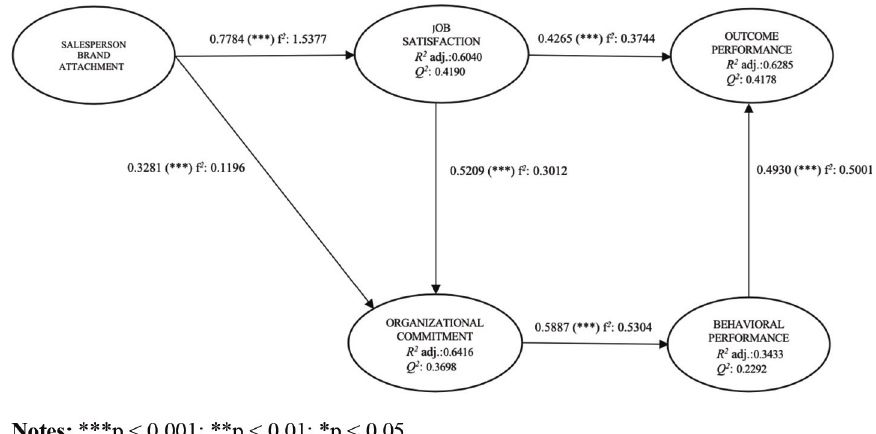
Figure 3. Alternative